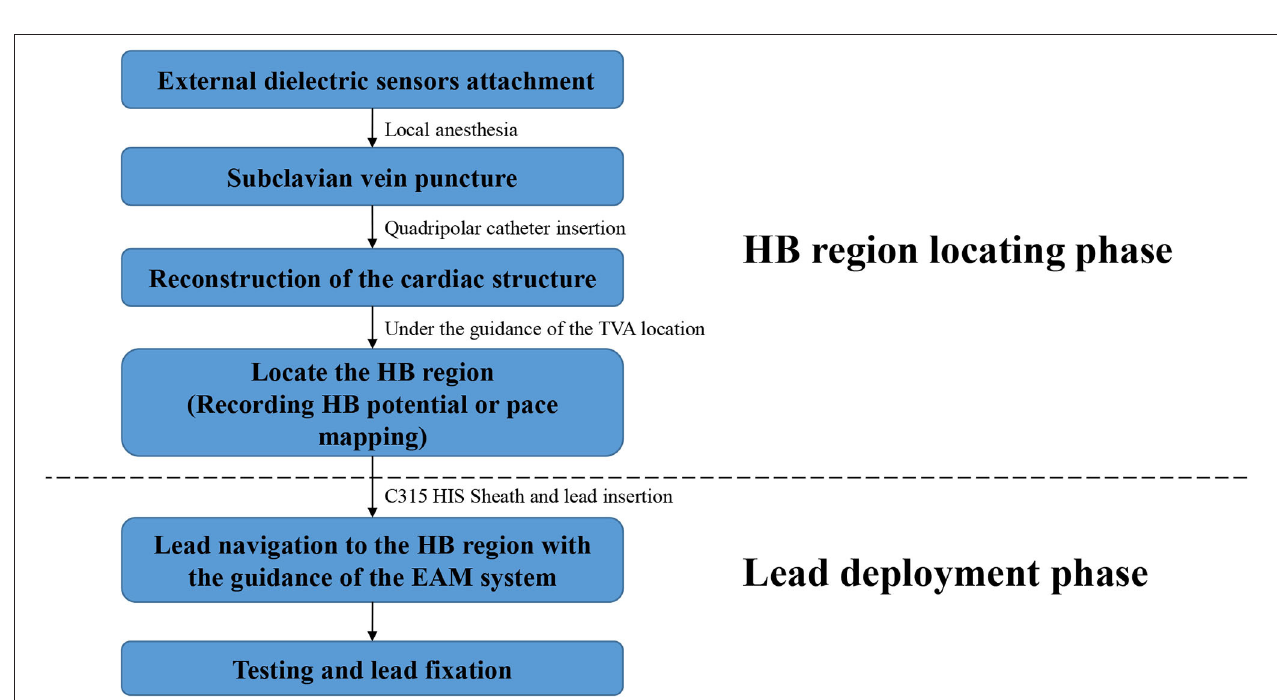
FIGURE 2 | Flowchart of the procedure details in the EAM-guided group. EAM, electroanatomical mapping; HB, His bundle. could be recorded was marked under the guidance of the TVA location. The pace mapping (usually 10 mA at 2 ms) was sometimes used to assist in locating the HB region, and the region where the paced QRS morphology showed a selective HBP (S-HBP) or nonselective HBP (NS-HBP) pattern was also marked as the HB region.